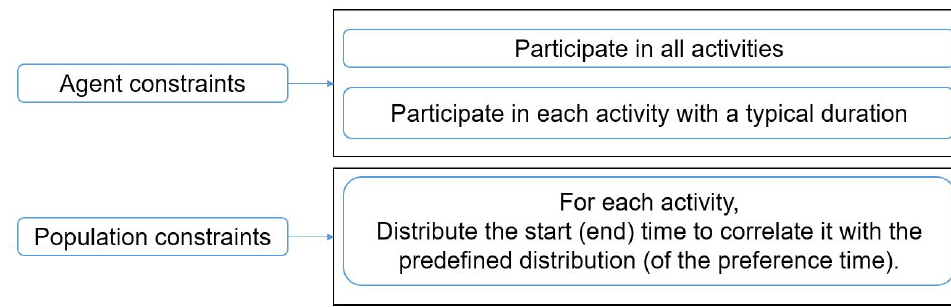
Figure 3. Agent-related and population-related